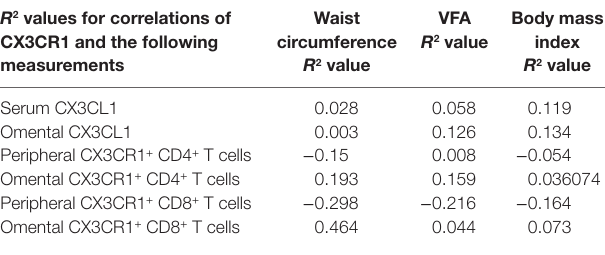
TaBle 2 | Correlations of CX3CL1 levels and frequencies of CX3CR1 NEG expressing T cells with waist circumference, visceral fat area (VFA), and body mass